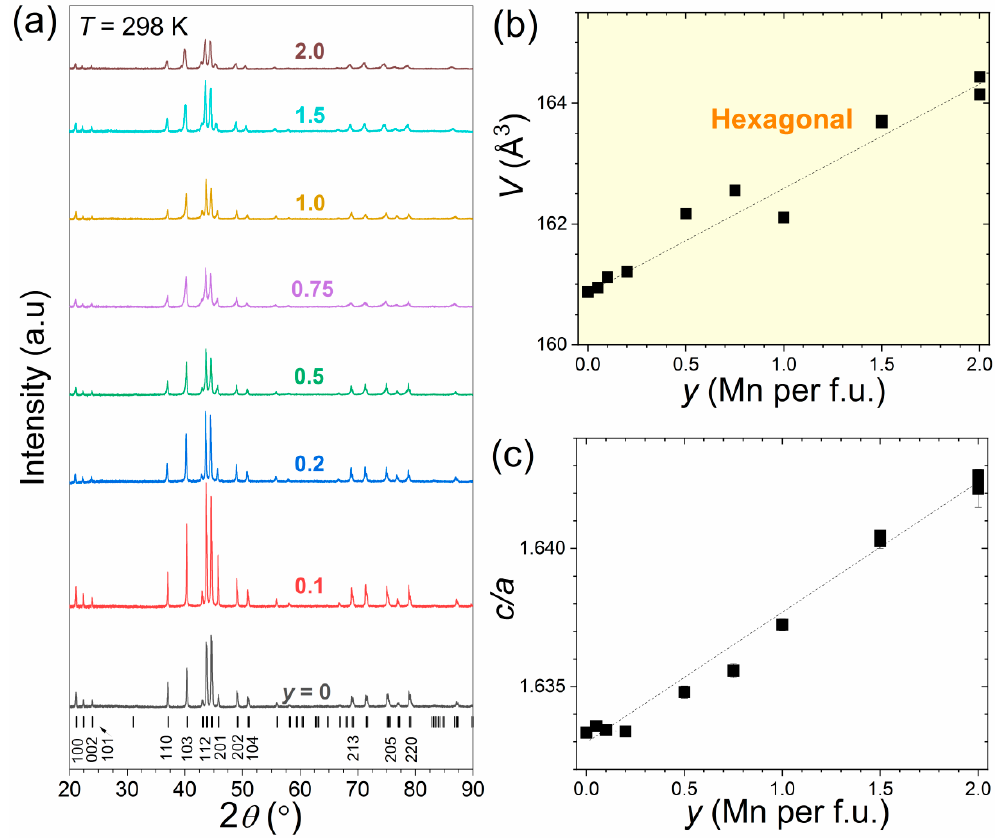
Figure 6. XRD patterns and structural parameters at room temperature of Sc 0.28 Ti 0.72 Fe 2 − y Mn y alloys as a function of Mn content ( y ): ( a ) XRD patterns measured at room temperature, with, at the bottom, ticks marking the reflections of the C14 hexagonal structure; ( b ) unit cell volume; and ( c ) ratio of the cell parameters.